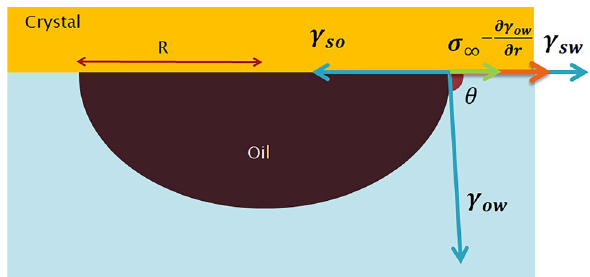
Fig. 7 Schematic diagram of different forces working along the contact line with their respective